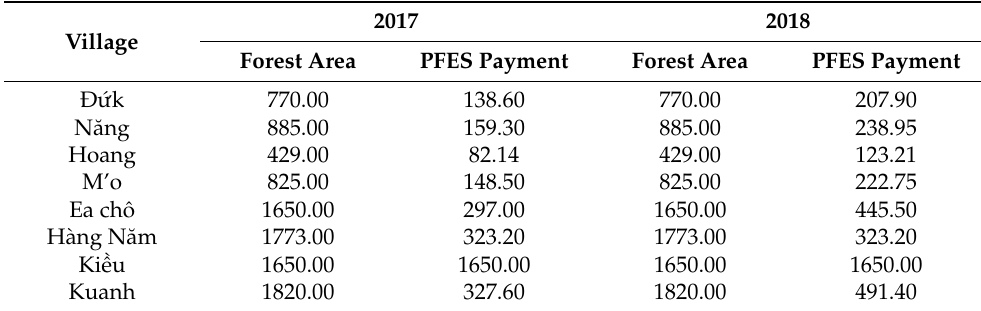
Table 5. PFES payments (VND × million) and forest area (ha) in the study sites.